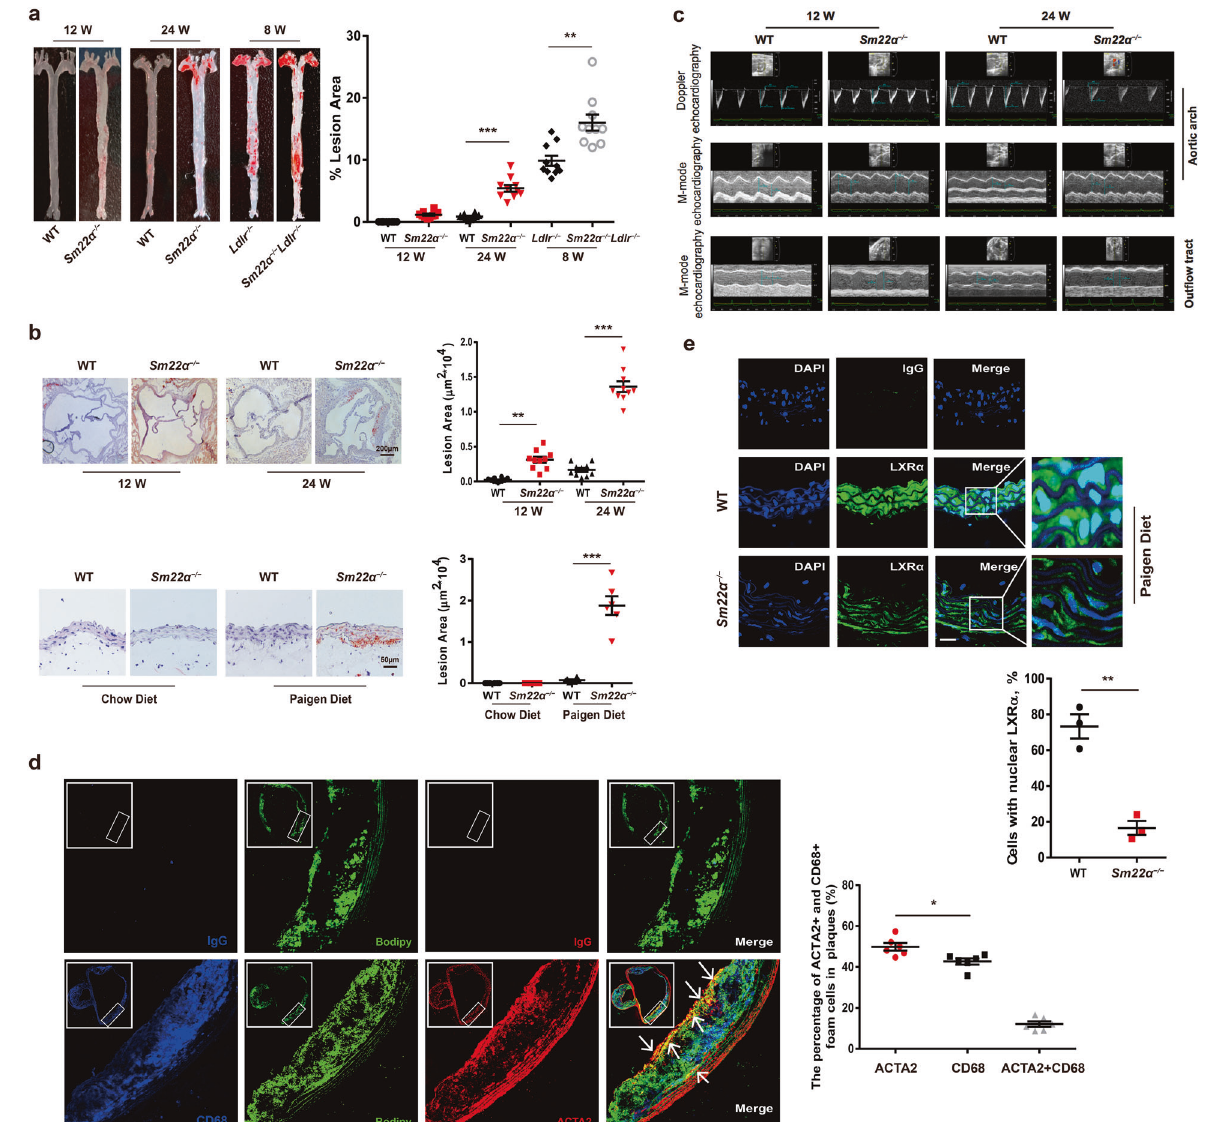
Fig. 1 Impaired SM22 α expression is associated with development of atherosclerosis. a , b WT ( n = 10) and Sm22 α − / − ( n = 10) mice with or without Ldlr − / − background ( n = 10) fed Paigen diet for 8, 12, and 24 weeks, respectively. Representative images of en face ORO-stained aortas ( a ), aortic sinus, aortic cross sections ( b ), and quanti fi cation of lesion areas are shown. c M-mode and Doppler echocardiography images obtained from aortic arch and out fl ow tract of WT ( n = 15) and Sm22 α − / − ( n = 15) mice fed Paigen diet for 12 and 24 weeks. A s : out fl ow tract and aortic diameter in systole; A d : out fl ow tract and aortic diameter in diastole. d Identi fi cation of SMC-derived foam cells within atherosclerotic lesion of Sm22 α − / − mice ( n = 6) by CD68 (blue), ACTA2 (red), and Bodipy (green). Scale bar, 20 µm. Arrows indicated foam cells, which were VSMCs-derived. e Representative immuno fl uorescence of LXR α (red) and quanti fi cation of cells with nuclear LXR α in the aortic sections from WT ( n = 3) and Sm22 α − / − ( n = 3) mice. Scale bar, 15 µm. Data and images are representative of at least three independent experiments. Data in a and b were analyzed by two-way and one-way ANOVA, respectively. Data in d and e were analyzed by unpaired t -test. * p < 0.05; ** p < 0.01; *** p < 0.001.